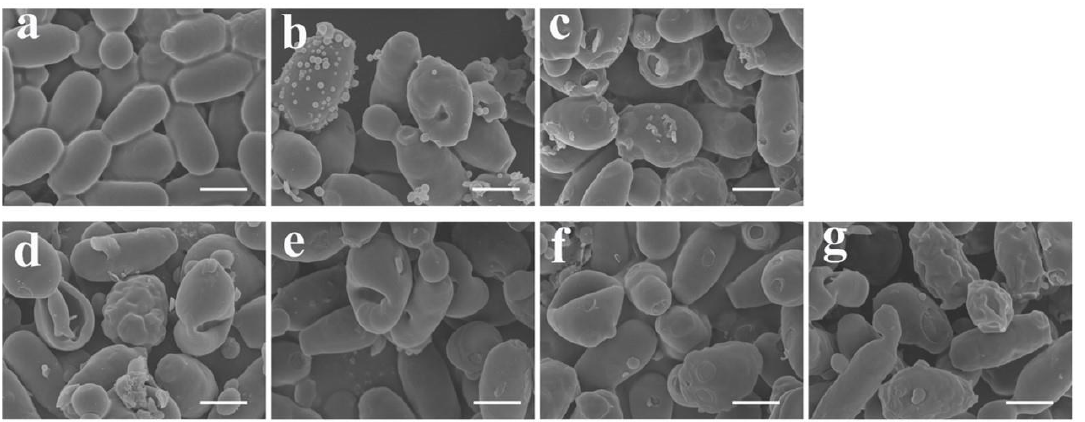
Figure 6. Morphological alternations in C. tropicalis cells upon treatment with antimicrobial peptides. Fungal cells were incubated for 2 h in 10 mM sodium phosphate bu ff er ( a ), 16 µ M HPA3NT3 ( b ), 16 µ M ME ( c ), used as controls. Hn-Mc at 16 µ M was incubated with fungal cells for 1 h ( d ), 2 h ( e ), 4 h ( f ), or 8 h ( g ). Scale bars, 5 µ